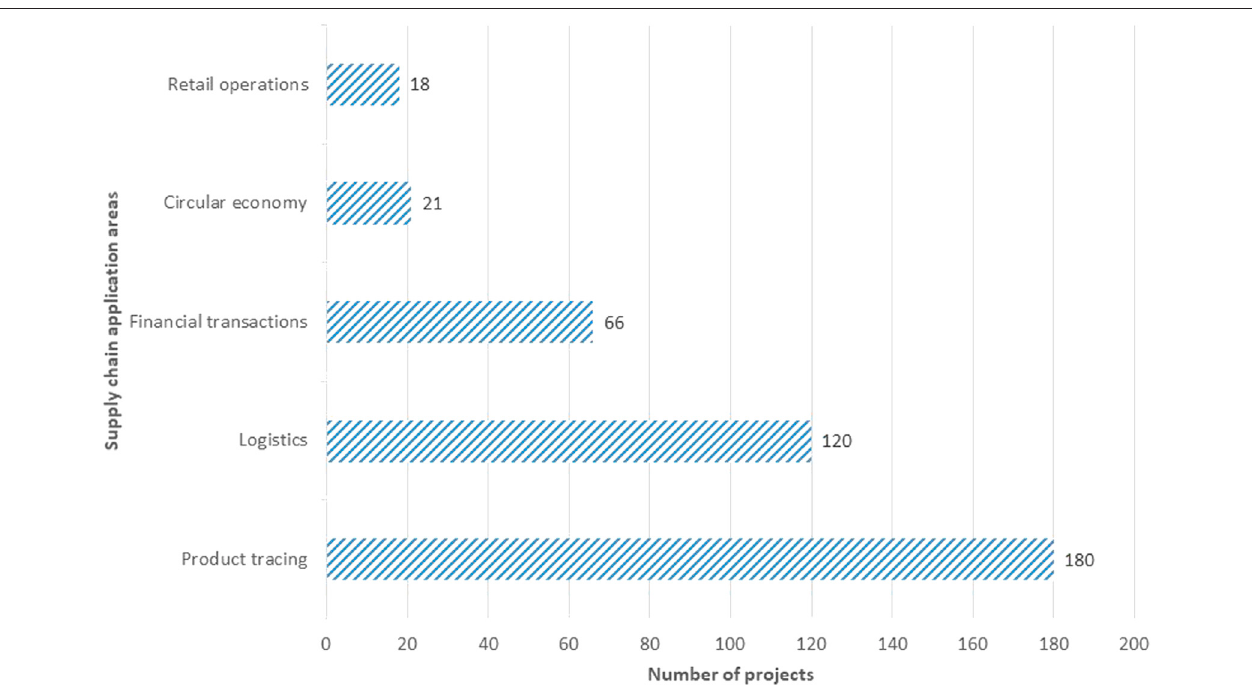
FIGURE 6 | The number of projects focused on a particular supply chain application area.